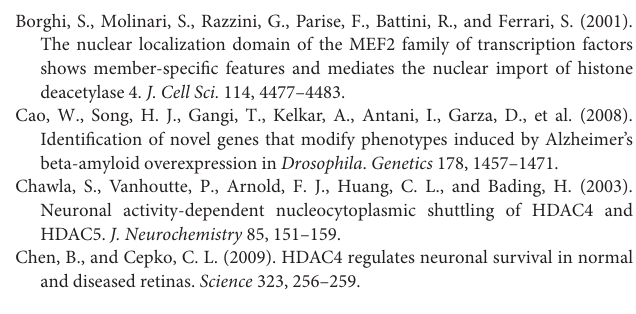
Supplementary Figure 1 | Confirmation of MEF2 knockdown and overexpression. A. elav-GAL4 females were crossed UAS-MEF2 RNAi males in order to knock down MEF2 in all neurons. RNA was isolated from heads and RT-qPCR for MEF2 was carried out with normalization to Ef1 α 48D. MEF2 was significantly knocked down to approximately 40% of wild-type [ t -test t ( 4 ) = 3.99, p < 0.05]. B. OK107-GAL4; tubP-GAL80 ts females were crossed to UAS-Myc-MEF2 or w(CS)10 males. Flies were raised at 18 ◦ C until after eclosion, then placed at 30 ◦ C 72 h prior to dissection to induce transgene expression. B. Whole-mount brains were processed for immunohistochemistry with anti-MEF2 (green) and anti-Myc (magenta). Optical sections (1 µ m) through the Kenyon cells show that Myc-MEF2 co-localizes with endogenous MEF2 in Kenyon cell nuclei, whereas there is no Myc-MEF2 expression in the control. Scale bar = 50 µ m. Supplementary Figure 2 | Mutation of the MEF2 binding site reduces binding of 3SA to MEF2. OK107-GAL4; tub-GAL80 ts females were crossed to UAS-Dm3SA and UAS-Dm3SA- (cid:49) MEF2 males, and expression was induced in the brains of adult progeny by raising the flies at 18 ◦ C until after eclosion, then placing at 30 ◦ C for 72 h. A. Whole-mount brains were subjected to immunohistochemistry with anti-Myc (green) and anti-MEF2 (magenta). Z-stacks were captured of 0.25 µ m slices, which were imaged at x100 magnification. Overlapping puncta appear white in the merged channel. B. The number of overlapping puncta in each section were counted using ImageJ in each of ∼ 40 sections through the Kenyon cell layer. Dm3SA- (cid:49) MEF2 ( n = 7 brains) displayed significantly reduced co-distribution with MEF2 in comparison to Dm3SA ( n = 5 brains) [ t -test t ( Supplementary Table 1 | Differentially expressed genes between control and L175A; control and 3SA; and 3SA and L175A groups. Genes with a False Discovery Rate of < 0.05 are